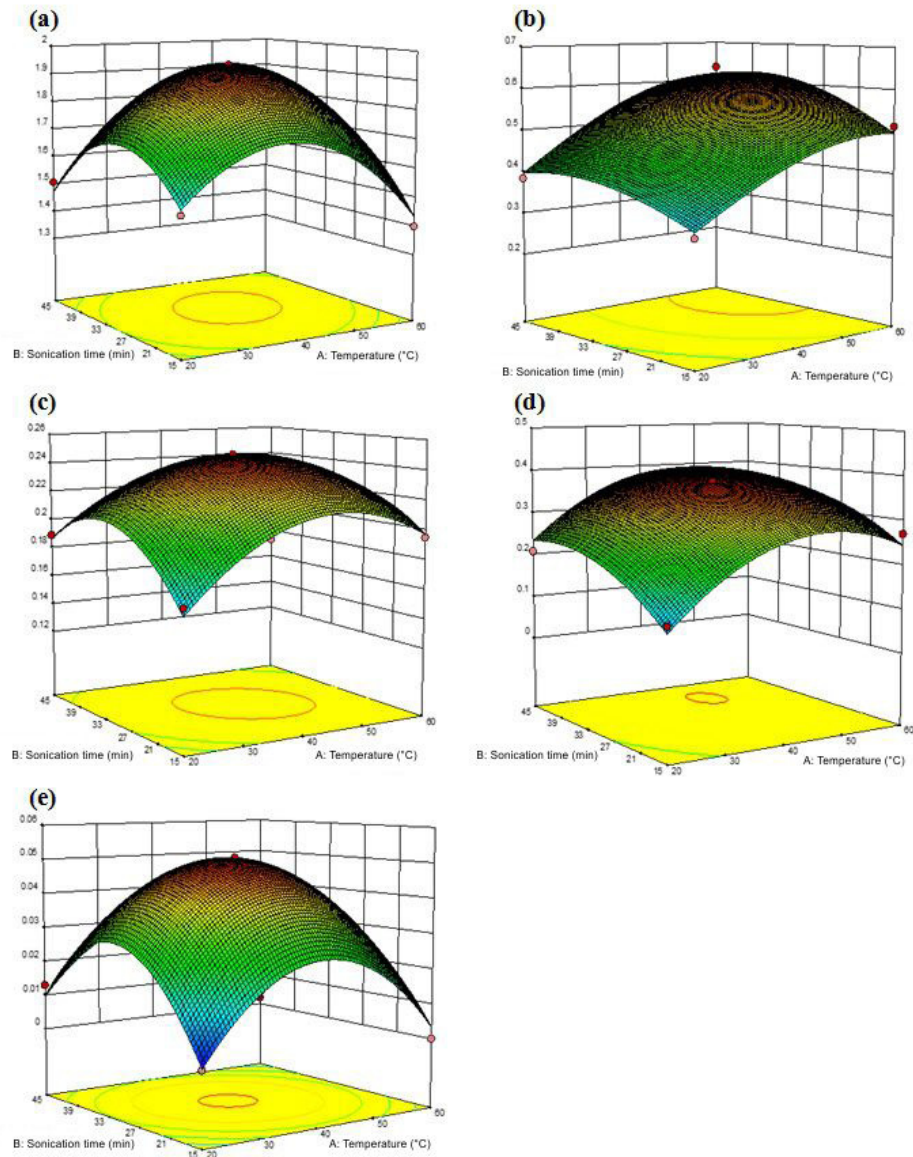
Fig. 3: 3D plots of ultrasound hydrolysis and extraction of bound phenolic acids (mg g -1 DW) from Coriandrum sativum L., varying sonication time and temperature (the concentration of NaOH is constant in the central point). (a) caffeic acid, (b) ferulic acid, (c) vanillic acid, (d) p-coumaric acid and (e) syringic